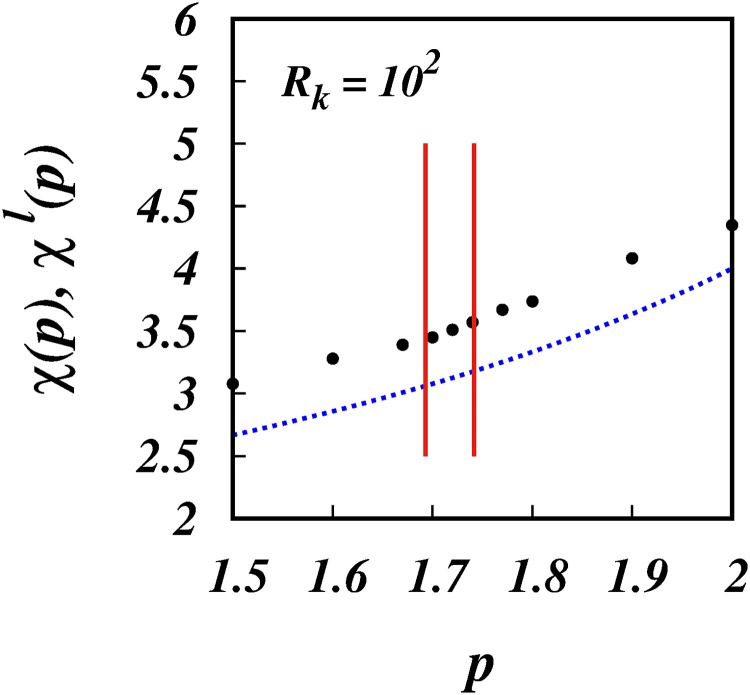
χ(p), χl(p), against p for Rk = 102.Similar to Fig 8, but focussing in the range of real turbulence with intermittency. The two vertical red lines are the lower and upper bounds for intermittent turbulence spectra, respectively p = 1.70 and 1.74.